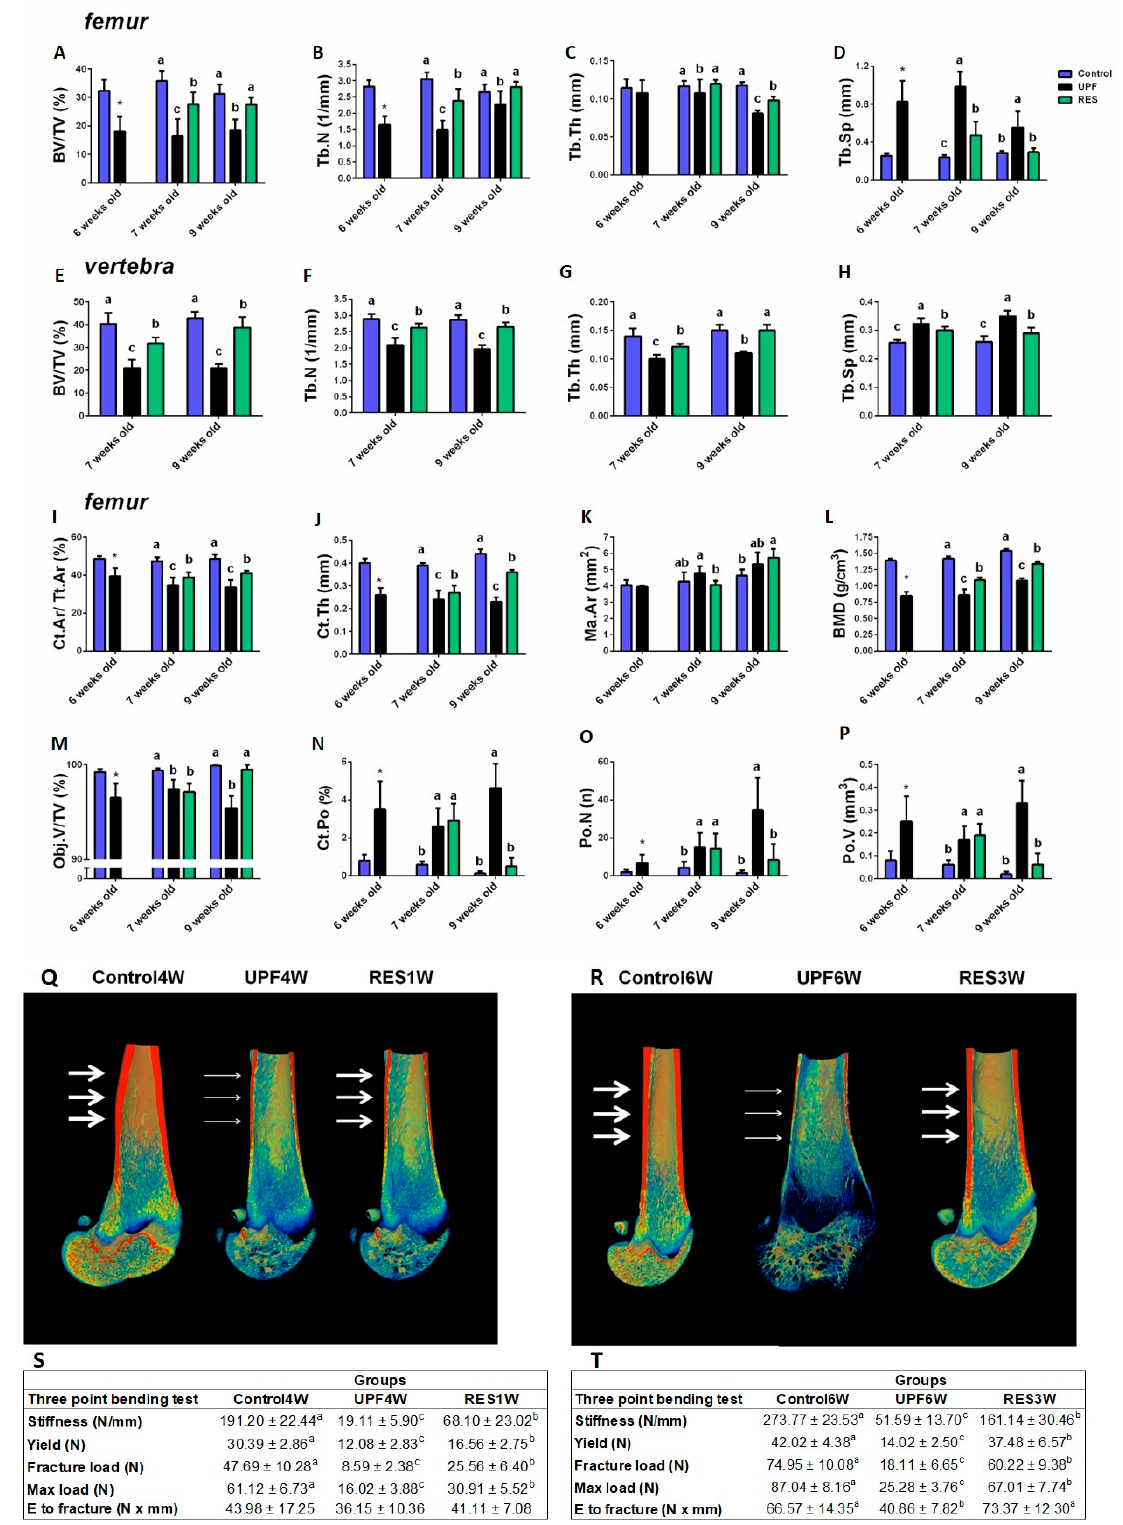
Figure 8. Short or prolonged transition to a balanced diet does not lead to a full recovery of cortical and trabcular bone or the bio-mechanical strength. Control and ultra-processed food (UPF) groups were compared to a group that received a Control diet for 1 week and 3 weeks following 3 weeks of a UPF diet (RES). ( A – H ) Trabecular parameters: bone volume fraction (BV/TV), trabecular num- ber (Tb.N), trabecular thickness (Tb.Th), and trabecular separation (Tb.Sp). ( I – L ) Cortical parame- ters: cortical area fraction (Ct.Ar/Tt.Ar), average cortical thickness (Ct.Th), medullary area (Ma.Ar),